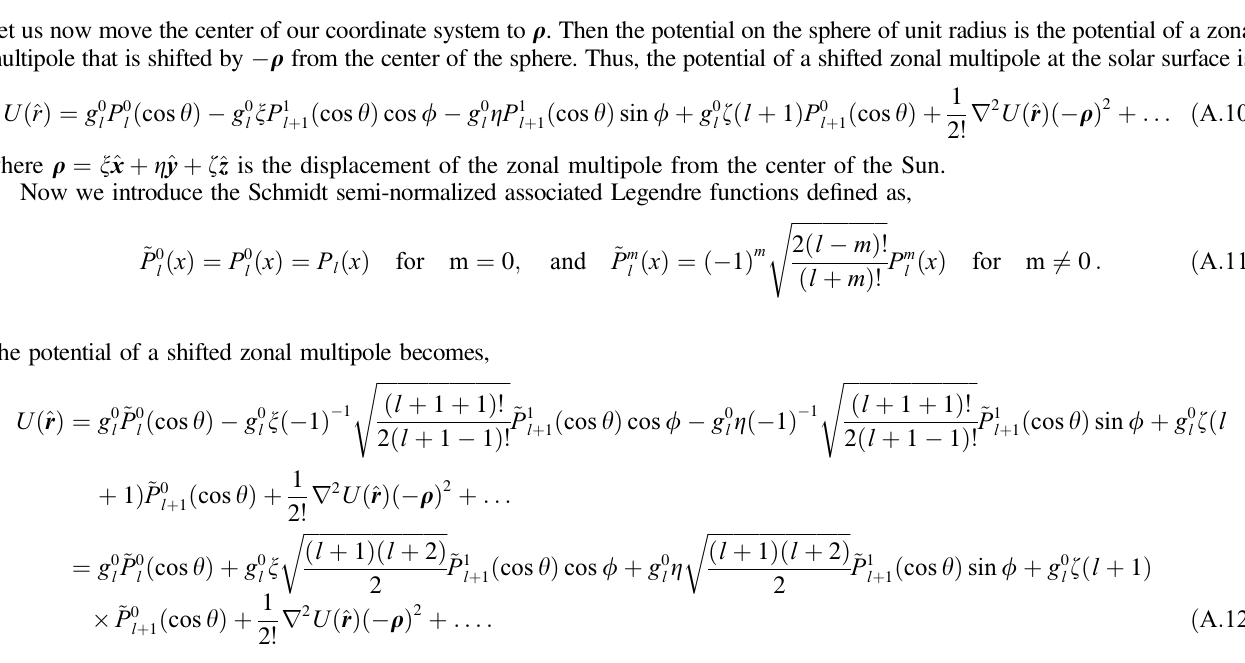
normalized associated Legendre